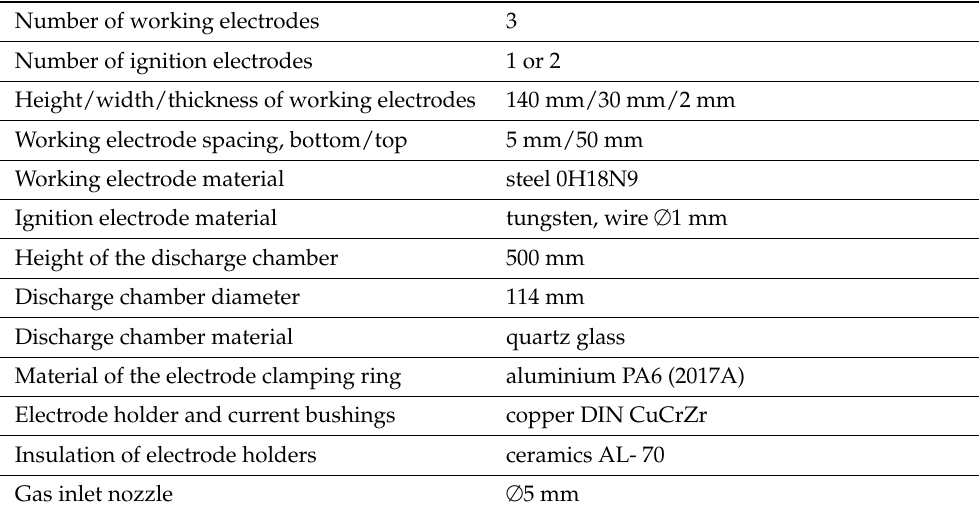
Figure 1. GlidArc-type plasma reactor, ( a ) overview drawing, ( b ) system with one ignition electrode, ( c ) system with two ignition electrodes, WE — working electrodes, IE — ignition electrodes. Table 1. Technical parameters of the plasma reactor.